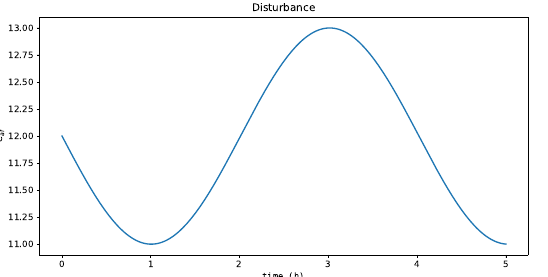
Figure 14. Process disturbance with sine wave dynamics outside the range used in the offline training.